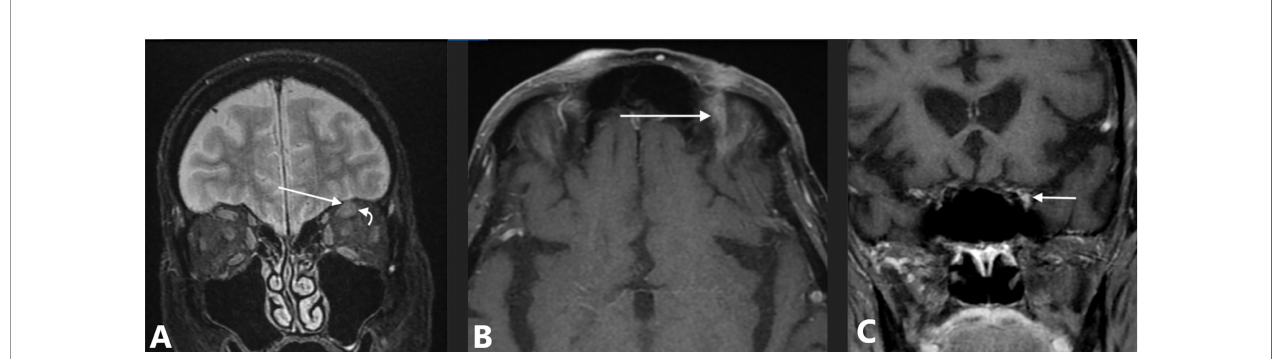
FIGURE 3 | Case 3: an 81-year-old man with squamous cell carcinoma and perineural spread along V1 to the cavernous sinus. (A) MRI with coronal fat- suppressed T2-weighted image shows intermediate signal intensity tumor involving V1 (straight arrow) adjacent to normal superior rectus muscle (curved arrow). (B) Axial fat-suppressed contrast-enhanced T1-weighted image shows abnormal enhancement in the superior orbit (arrow). (C) Coronal contrast-enhanced T1- weighted image, obtained just posterior to the superior orbital fi ssure, shows asymmetric enhancement and fullness along the lateral margin of the cavernous sinus (arrow).